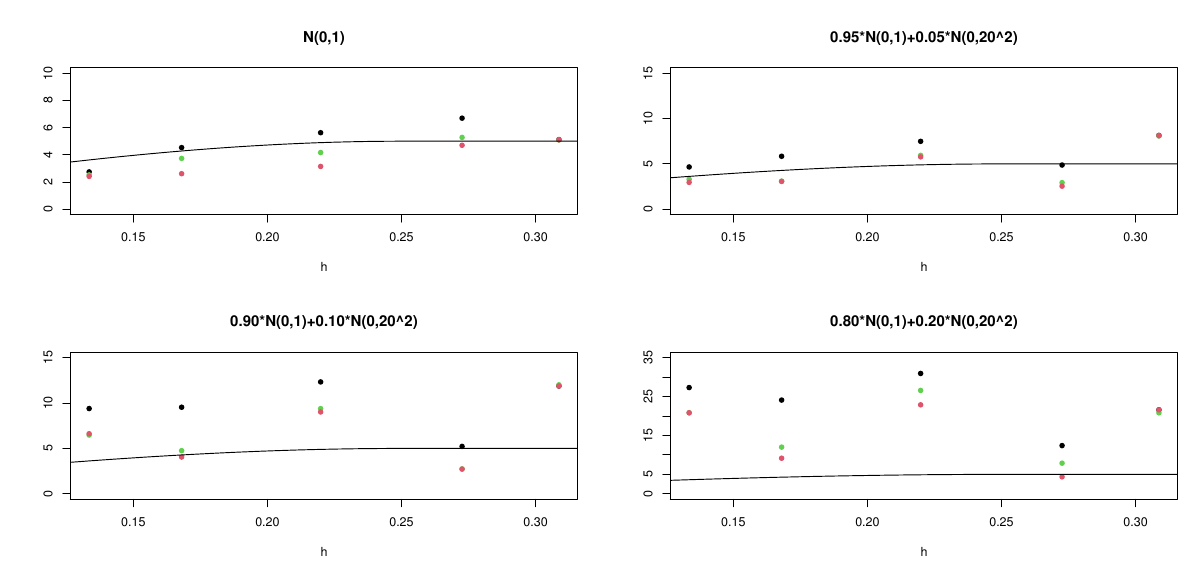
Figure 5. Variogram estimations of Example 1: classical (black), 0.1-trimmed (green) and Huber’s (red), and the variogram model with no